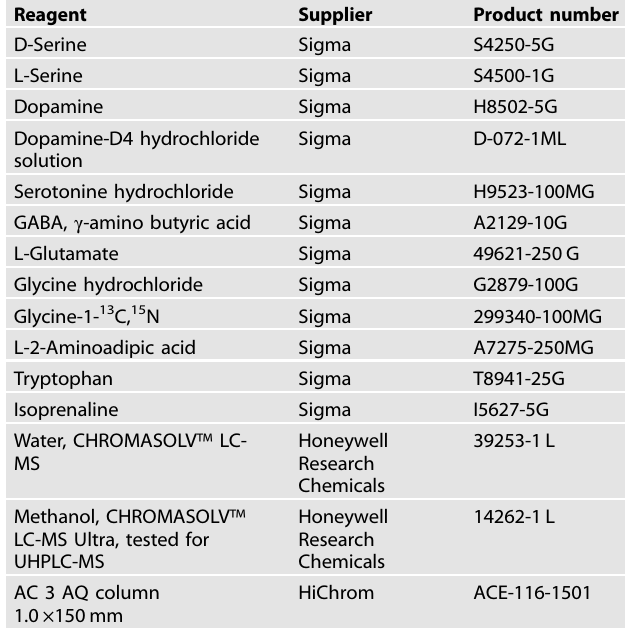
Table 1. List of reagents, supplier and product